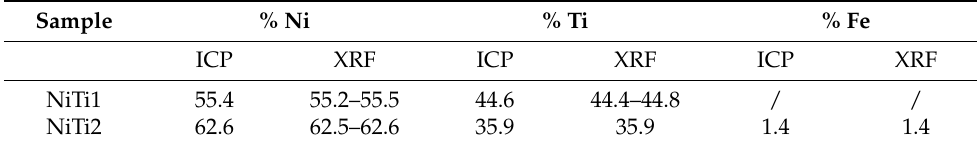
Table 1. Chemical composition of the NiTi1 and NiTi2 samples.